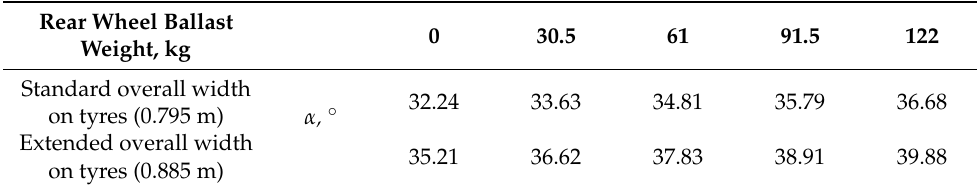
Figure 11. Comparison of static overturning angle calculated according to standard [12], [12] considering the vertical tyre deformation and tyre shift with experimental data: ( a ) standard overall width on tyres ( o = 0.795 m), ( b ) extended overall width on tyres ( o = 0.885 m).